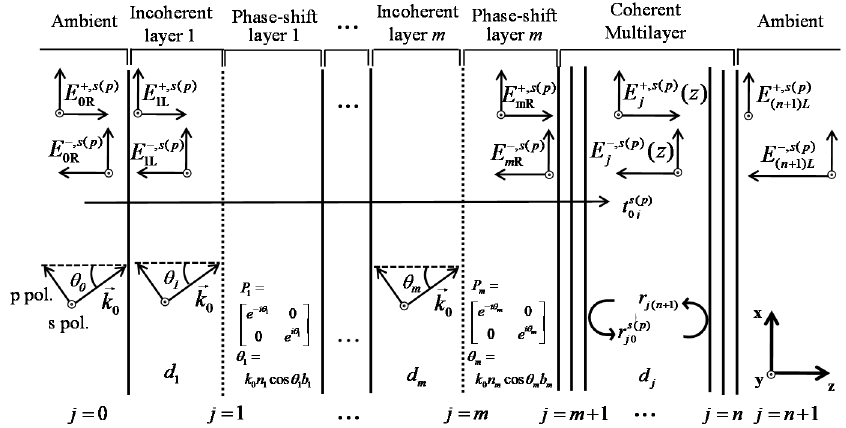
Figure 1. Schematic diagram of a planar mixed coherent-incoherent thin-film multilayer structure. The multiple incoherent layers ( j = 1, ··· , m ) are assumed to be transparent and the remaining coherent layers ( j = m + 1, ··· , n ) can be either transparent or absorptive. To optically model random phase variations in the incoherent layers, each incoherent layer ( v = 1, ··· , m ) is divided into an initial layer of the original thickness d v and an additional phase-shift layer of the equispaced phase thickness b v . A plane wave is obliquely incident from the semi-infinite transparent ambient on the left ( j = 0) with the incidence angle θ 0 . The directions of the s- and p-polarized light are orthogonal to or parallel to the plane of incidence.